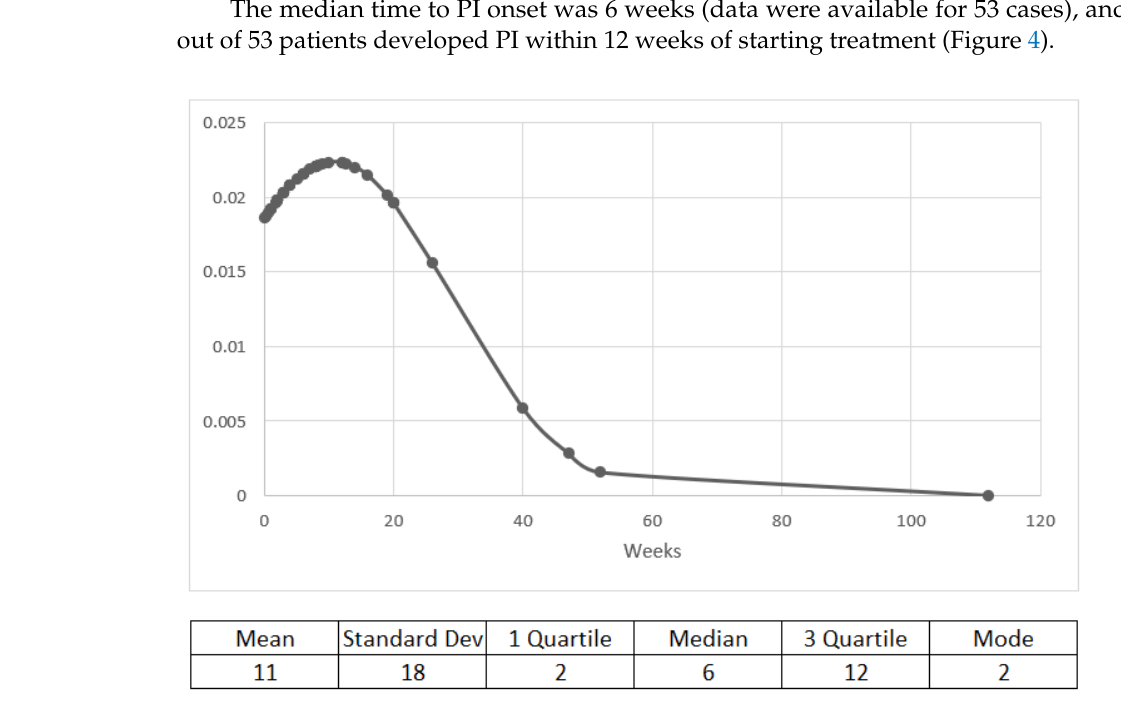
Figure 5. Overview of pneumatosis intestinalis management. Table 3. Clinical presentation and outcome of PI. PI details — No (%) Oncological (72 Cases)